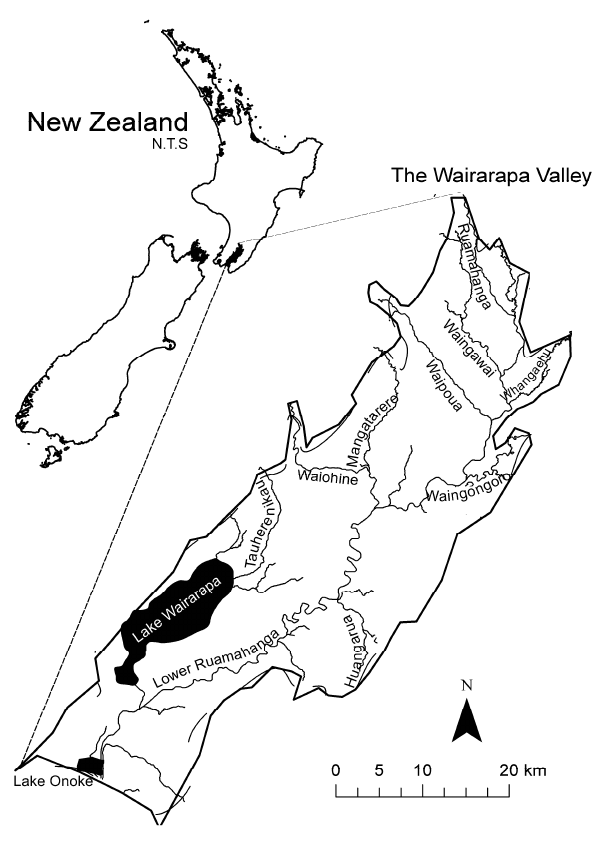
Fig. 1. Location of Wairarapa Valley and major river systems, North Figure 1. Location of Wairarapa Valley and major river systems, North Island, New Zealand. 3 Island, New